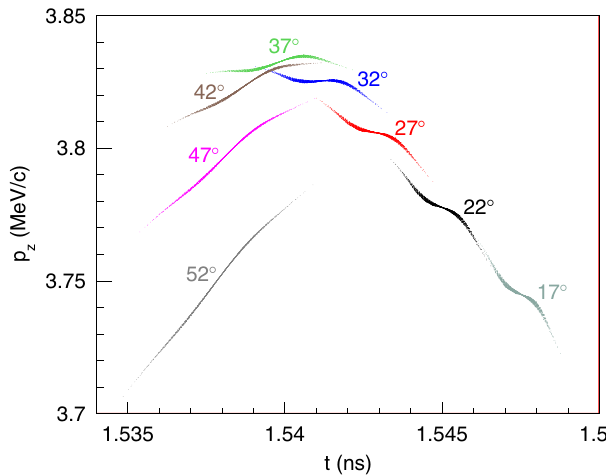
FIG. 15. Beam longitudinal phase space at 0.45 m for various beam launch phases. If a beam is launched at 37 (cid:3) (maximum beam energy gain phase), the beam becomes almost flat in the longitudinal phase space. If the launch phase is shifted toward 90 (cid:3) , the beam is configured such that the beam head has a higher energy than the beam tail. If the phase is toward the 0-crossing, the beam head has a lower energy than the tail. The beam is compressed by using velocity bunching at the buncher afterward.